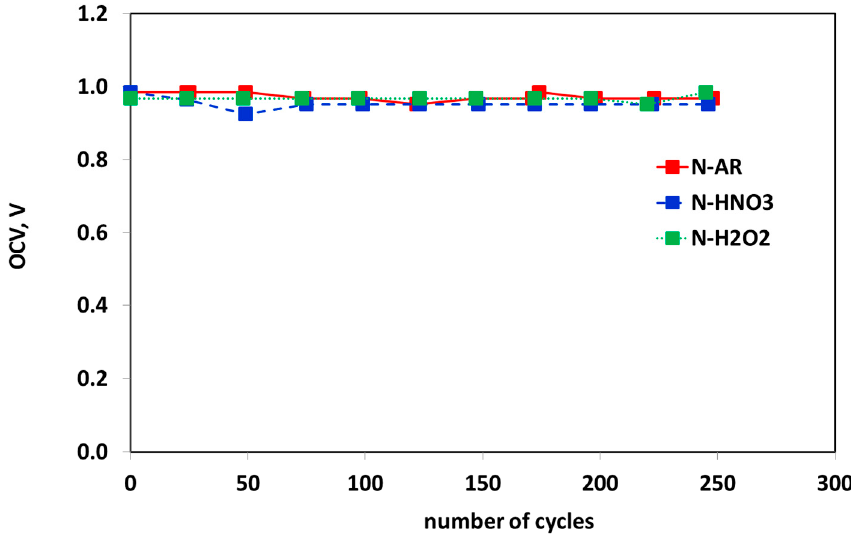
Figure 11. OCV trend during ASTs for N-AR (red squares), N-HNO3 (blue squares) and N-H2O2 (green squares) membranes.